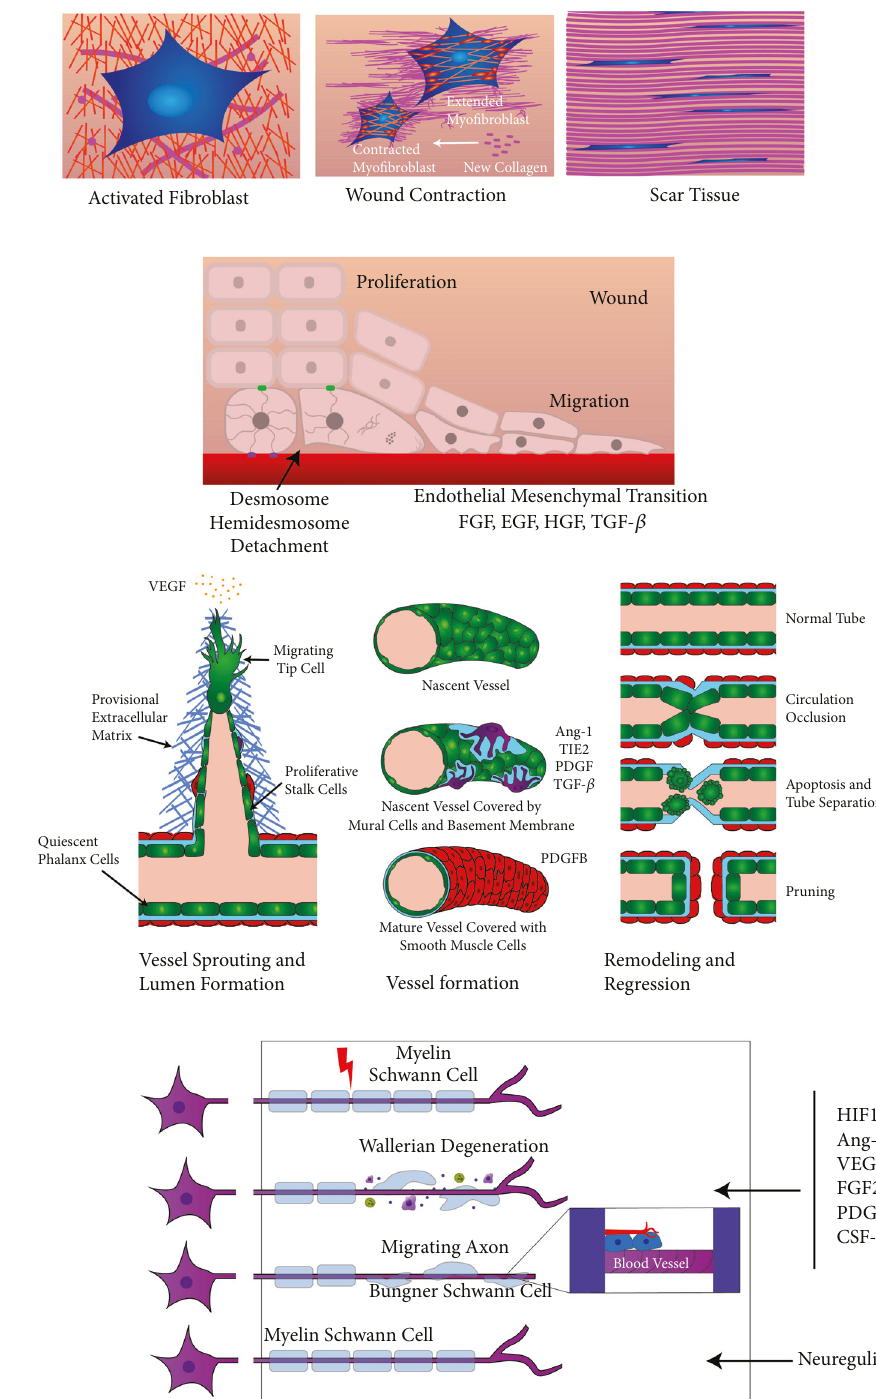
Figure 3: See Sections 5.4.1 to